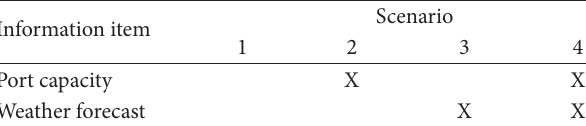
Table 1: Scenarios of information